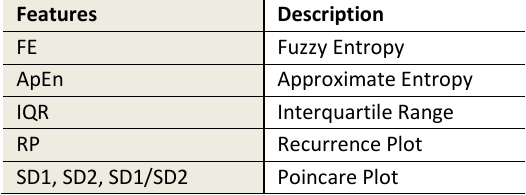
Table 2. List of non-linear features that are extracted from the DT-CWT coefficients in this